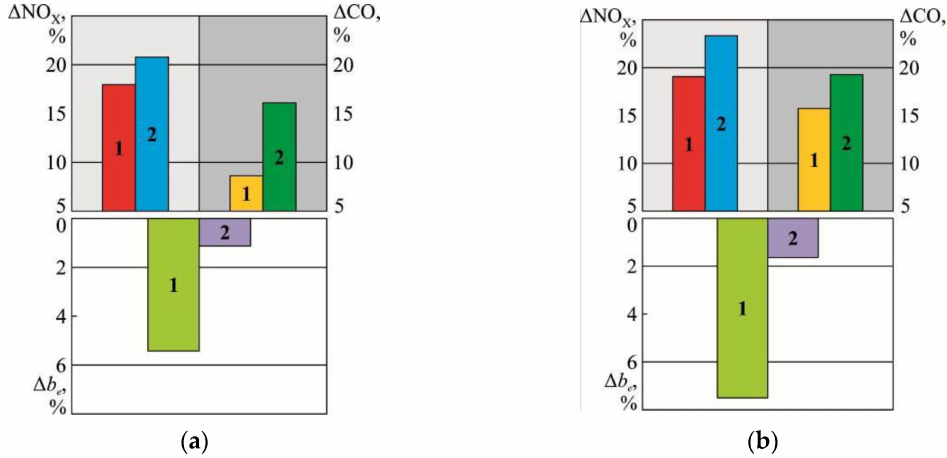
Figure 5. Optimal use of FAME biofuels in marine diesel 6N165LW Yanmar: ( a )—RMA10 + 10% biofuel; ( b )—RMA10 + 15% biofuel; 1—load 50%; 2—load